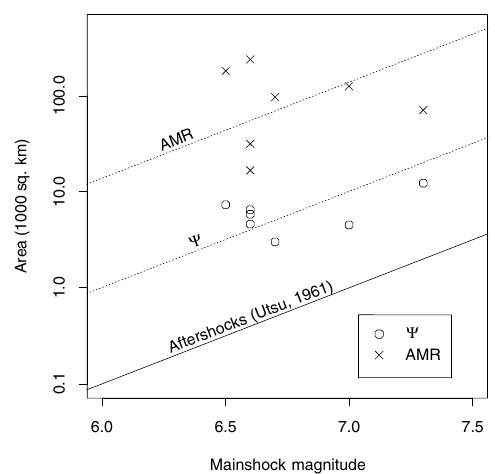
Fig. 5. (cid:115) and AMR precursory areas versus main- shock magnitudes for the earthquakes at Borrego Mountain (1968, M 6.5); San Fernando (1971, M 6.6); Coalinga (1983, M 6.7); Superstition Hills (1987, M 6.6); Loma Prieta (1989, M 7.0); Landers (1992, M 7.3), and Northridge (1994, M 6.6). The Utsu (1961) relation between aftershock area and mainshock magnitude is shown for comparison, and parallel lines are fitted to the AMR and (cid:115)